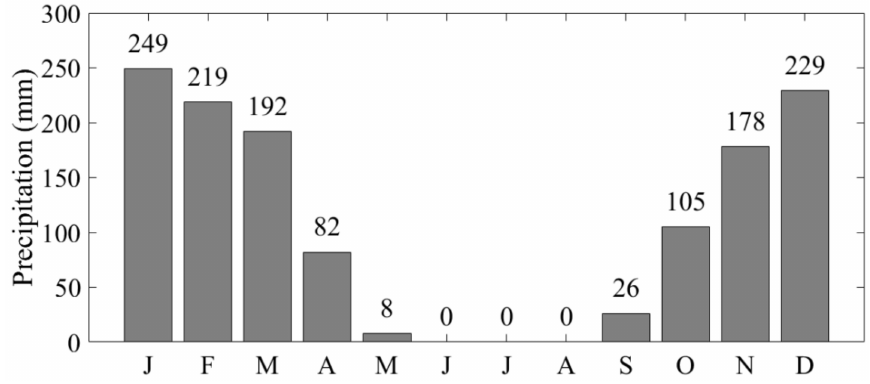
Figure 2. Probable average monthly precipitation (mm) estimated at the 75% probability level for the north–central region of the State of Mato Grosso,